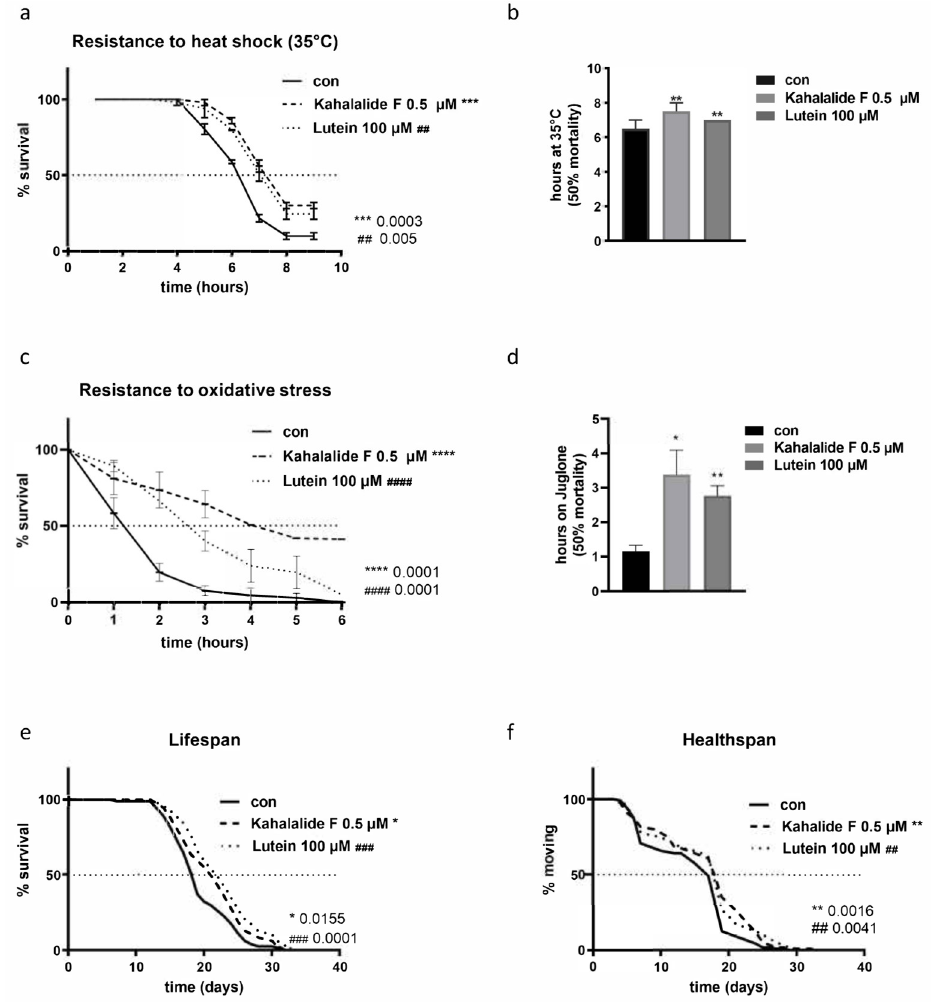
Figure 5. Lutein and kahalalide F promote health and lifespan. ( a ) Heat shock resistance over time in wild-type nematodes treated either with DMSO as control, or 0.5 µ M kahalalide F or 100 µ M lutein. ( b ) Bar graph showing the time (in hours) at which the 50% mortality was reached for each treatment. ( c ) Juglone resistance over time in wild-type nematodes treated either with DMSO as control, or 0.5 µ M kahalalide F or 100 µ M lutein, final Juglone concentration 200 µ M. ( d ) Bar graph showing the time (in hours) at which the 50% mortality was reached for each treatment. ( e ) Lifespan, shown as % of surviving animals over time and ( f ) healthspan, calculated as % of moving animals, among surviving nematodes over time. Asterisks (*) denote statistical significance: * p value ≤ 0.05, **, ## p value ≤ 0.01, ***, ### p value ≤ 0.001, ****, #### p value ≤ 0.0001 compared with